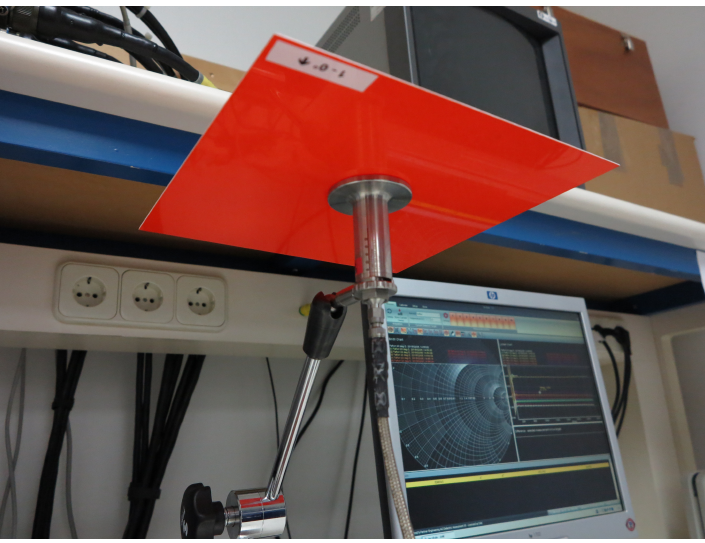
Figure 4. Open-ended coaxial probe